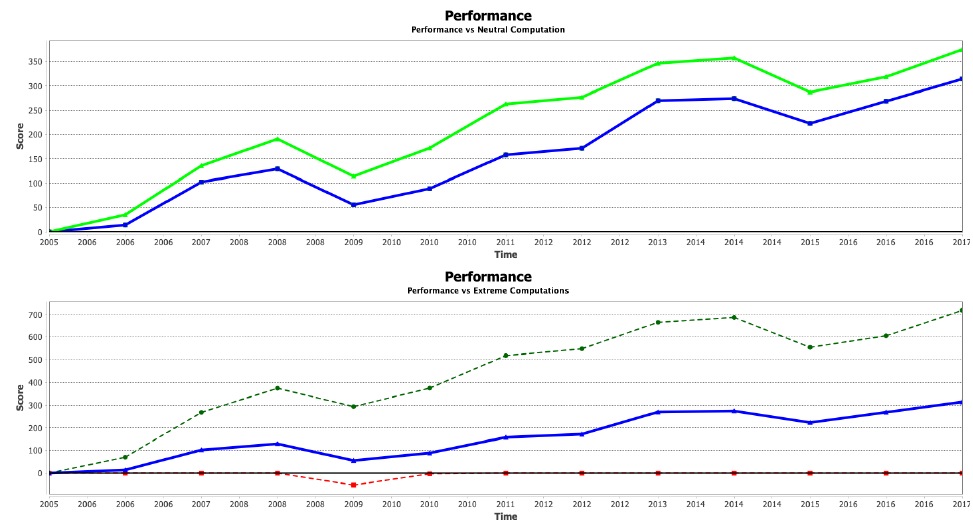
Figure 14. Analysis result (Case Study 2). The system performance is represented by the blue line, while the continuous green line refers to the neutral computation. Dashed lines are extreme